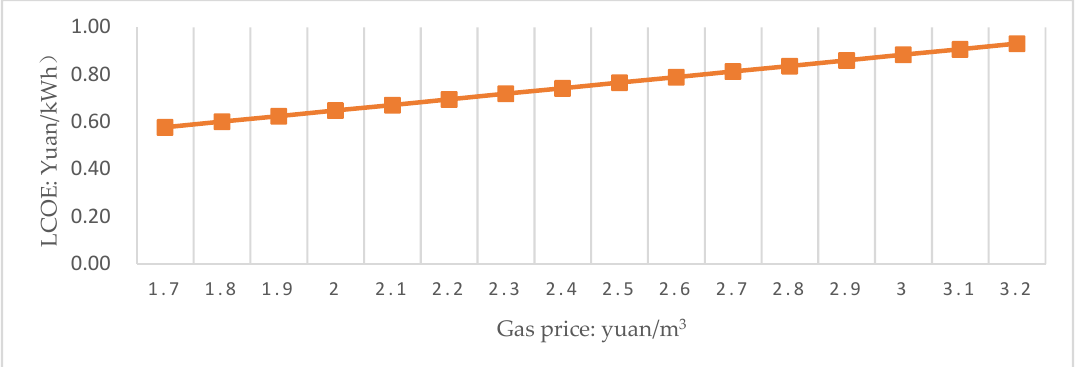
Figure 23. LCOE under different gas prices in centralized scenario.